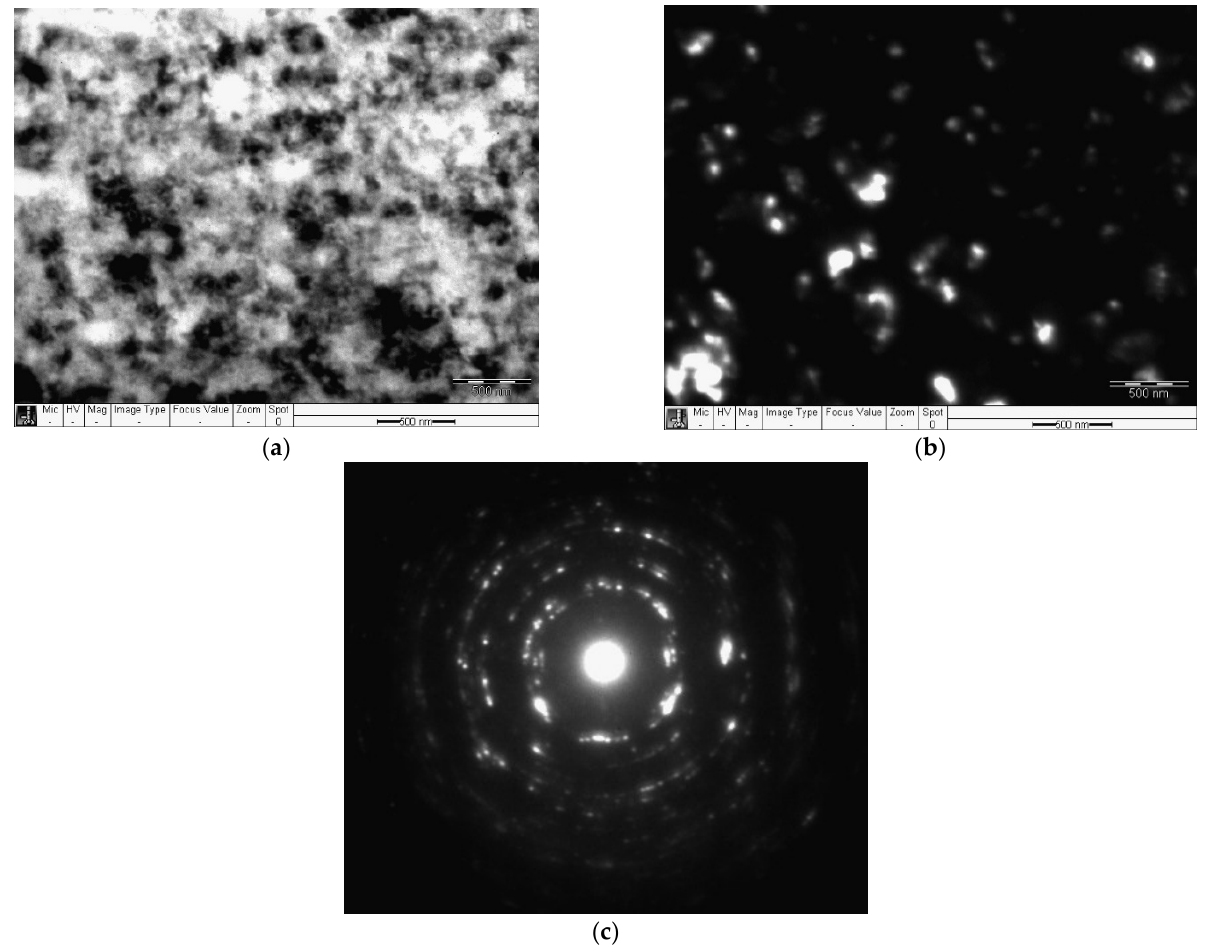
Figure 4. Structure of Ti after HPT n = 10: ( a ) bright field; ( b ) dark field; ( c ) electronogram. How can strain accumulate in the sample at HPT if slippage occurs? One of the possible explanations: it can be argued that the planes of the upper and lower anvils are inclined from each other by a small degree. Figure 5 shows a view of a Ti disk sample after HPT.